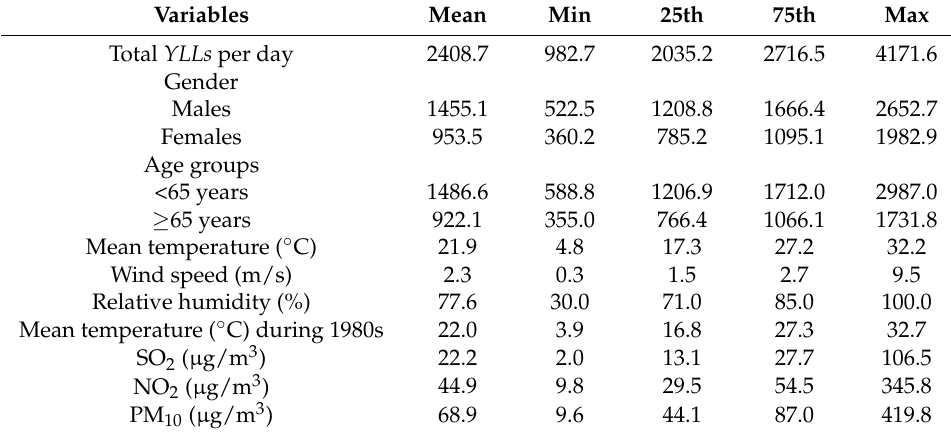
Table 1. Mean, range, and specific percentiles for studied variables in Guangzhou during